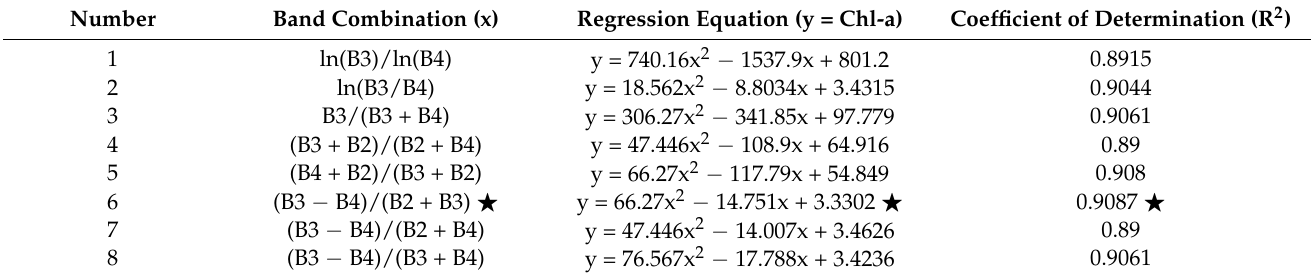
Table 3. Eight retrieved formulas of Chl-a of